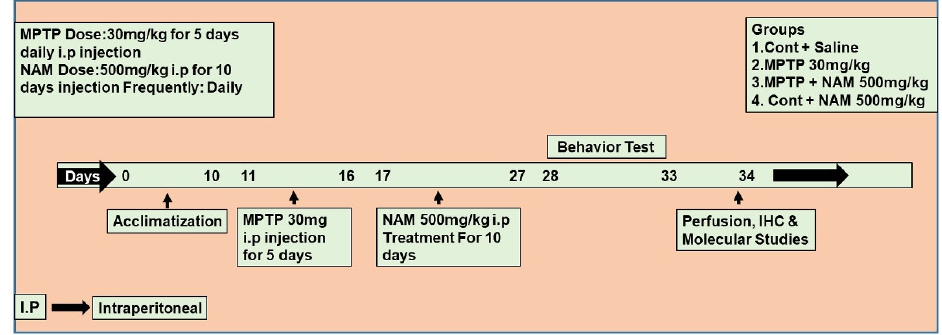
Figure 1. Schematic diagram of the experimental design. Treatment duration and behavioral analy ‐ sis of the experimental